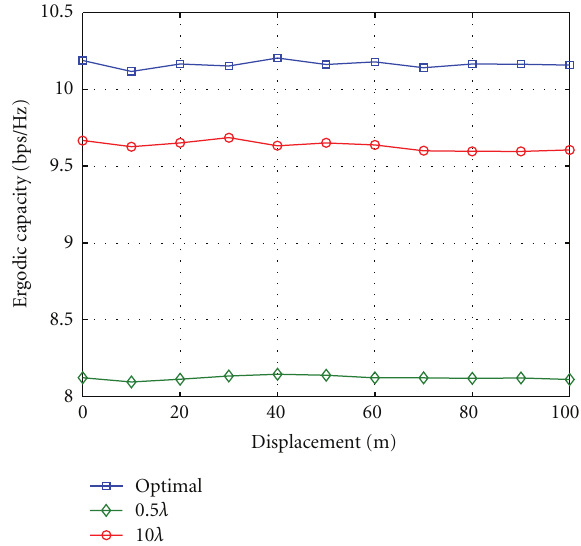
Figure 6: Ergodic capacity as a function of the displacement from the optimum